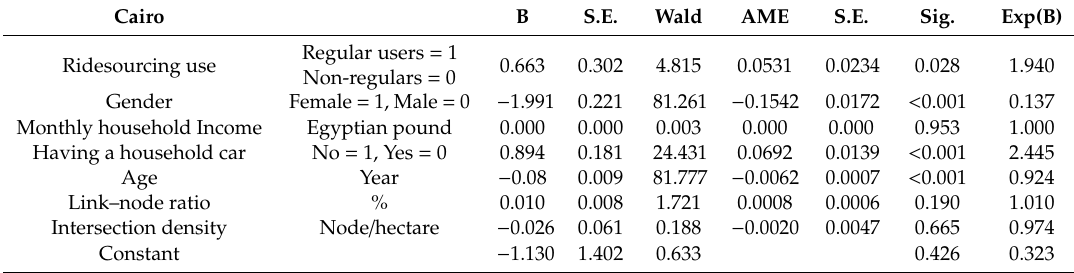
Table 4. Binary logit regression for cycling to near destination in